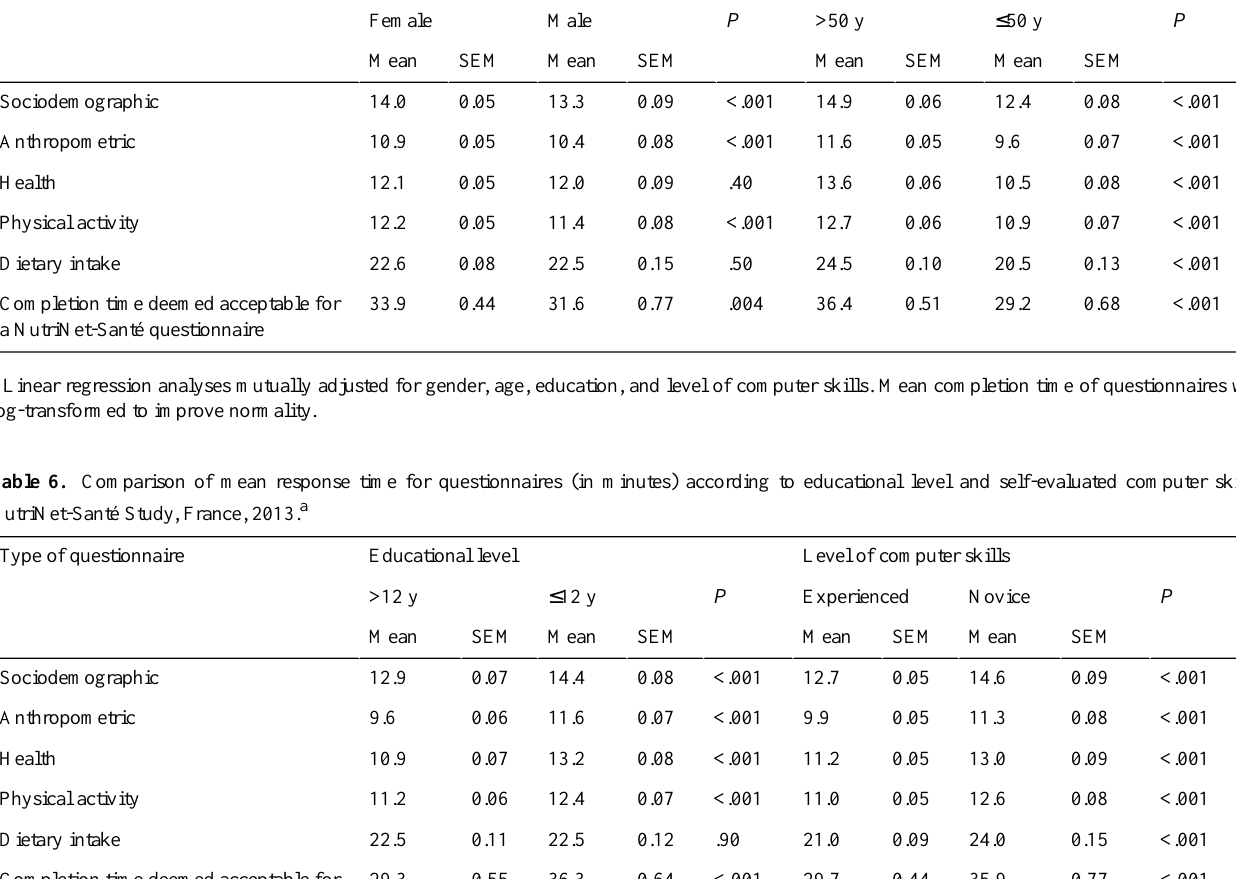
AgeGenderType of questionnaire